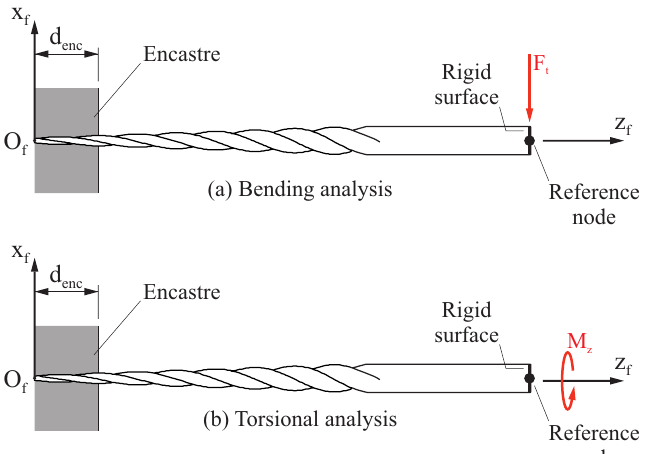
Figure 4. Definition of loading and boundary conditions.